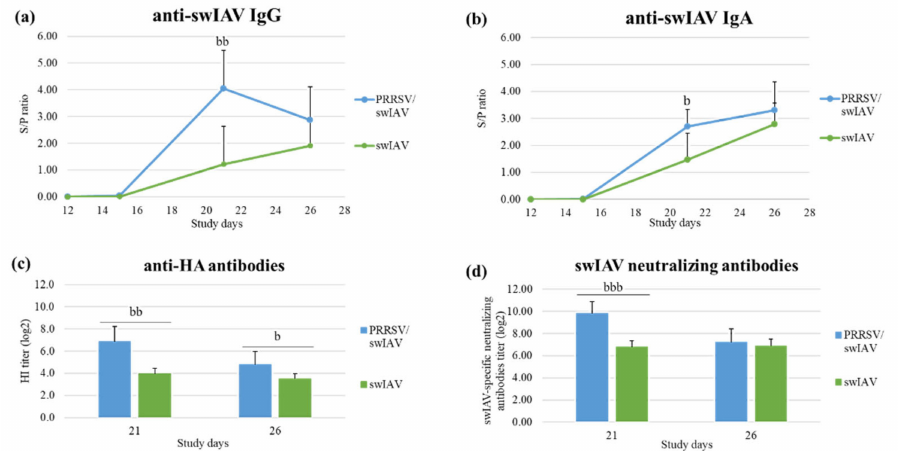
Figure 5. Anti-swIAV antibodies in BALF from infected groups. ( a ) IgG and ( b ) IgA (NP protein) levels. ( c ) Anti-HA antibody and ( d ) swIAV-neutralizing antibody titers. Data are reported as means ( ± standard deviation) of results obtained from pigs ( n = 6) in the PRRSV/swIAV (blue) and swIAV (green) groups. b: p < 0.05; bb: p < 0.01; bbb: p < 0.001. SD0: PRRSV inoculation; SD8: swIAV